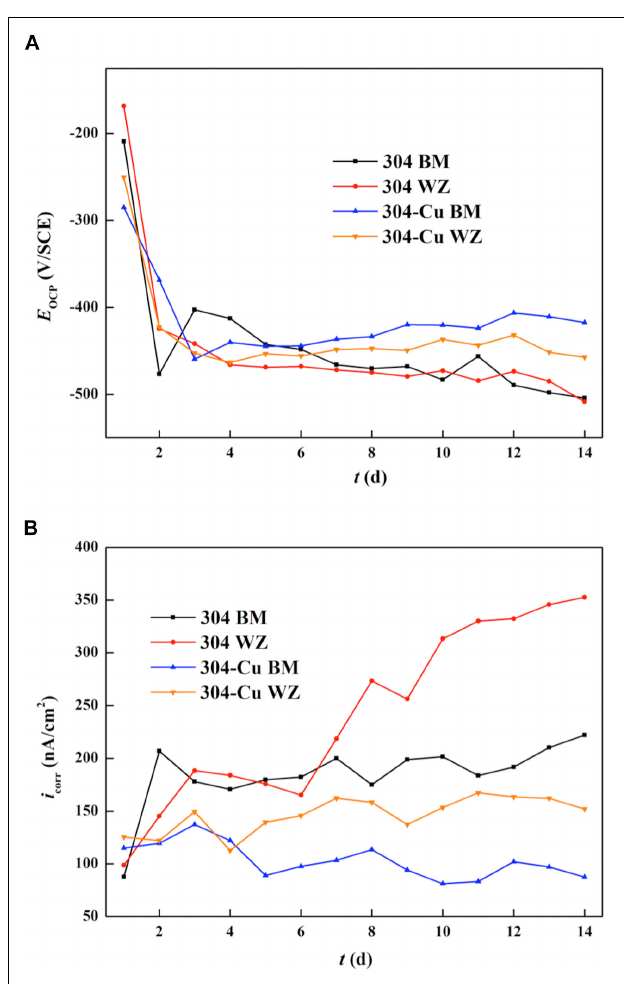
FIGURE 6 | Changing curves of (A) OCP and (B) LPR values for various electrodes during 14 days. OCP, open circuit potential; LPR, linear polarization